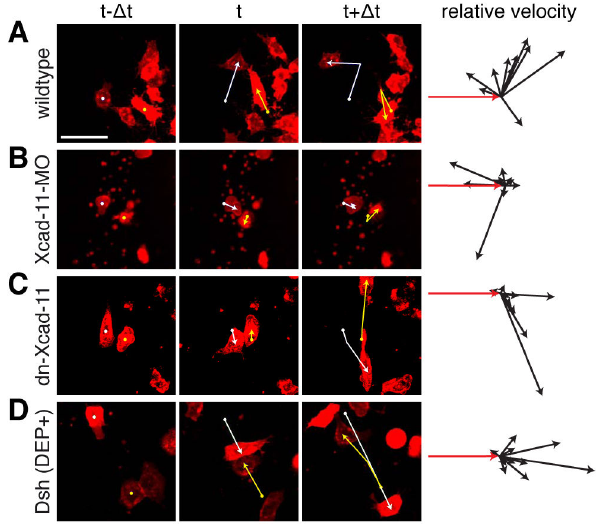
Figure 4. Xcad-11 mediates repulsive response in colliding in single CNC cells in vitro . Collision assay. First three columns: Single CNC cells before (t-Δ), during (t) and after (t+Δ) mutual contact with tracking. Fourth column: Relative velocity vectors with initial velocity vector (red, n = 10 collisions). (A) Only wildtype CNC cells showed change of direction. (B) Xcad-11-MO treated cells show random